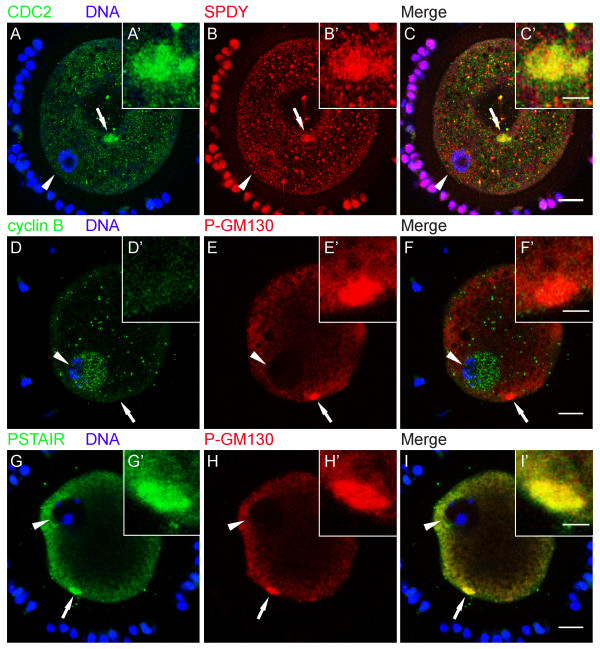
CDC2 associates with SPDY at ERES. (A-C) 0 h GV stage oocyte labeled for CDC2 (A, green), DNA (A, blue), and SPDY (B, red). Both CDC2 and SPDY localize to the same cortical domain (C). Note that the center of this oocyte is dented (the area that contains the arrow) causing the structure to appear in the middle of the oocyte, whereas it is located in the cortex. (D-F) 0 h GV stage oocyte stained for Cyclin B (D, green), DNA (D, blue), and P-GM130 (E, red). Cyclin B did not localize to the P-GM130-labeled cortical domain (F). (G-I) 0 h GV stage oocyte labeled for PSTAIR (G, green), DNA (G, blue), and P-GM130 (H, red). Spatial overlap of PSTAIR and phosphorylated GM130 staining (yellow) in a cortical domain is evident in the merged image (I). Images are Z-projections of 2 (A-C) or 3 (D-I) consecutive sections; scale bars represent 20 μm in C, F, and I, and 5 μm in C', F', and I'. Arrows indicate the region of the oocyte that is shown enlarged in the insets (A'-I'). Arrowheads denote the position of the GV.